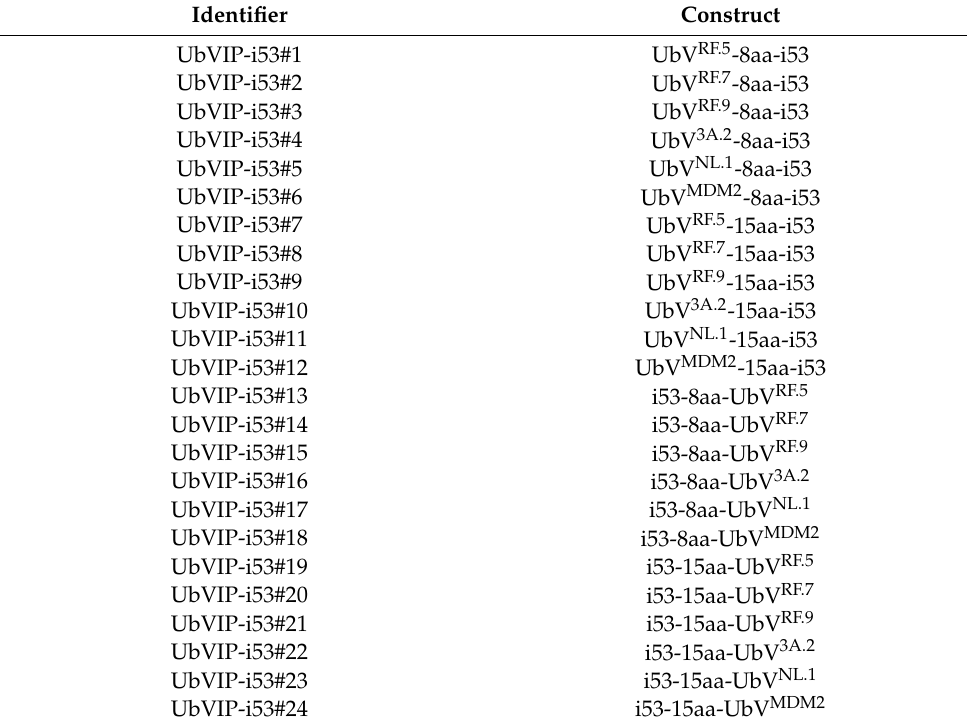
Table 1. List of UbVIP constructs and the corresponding identifier